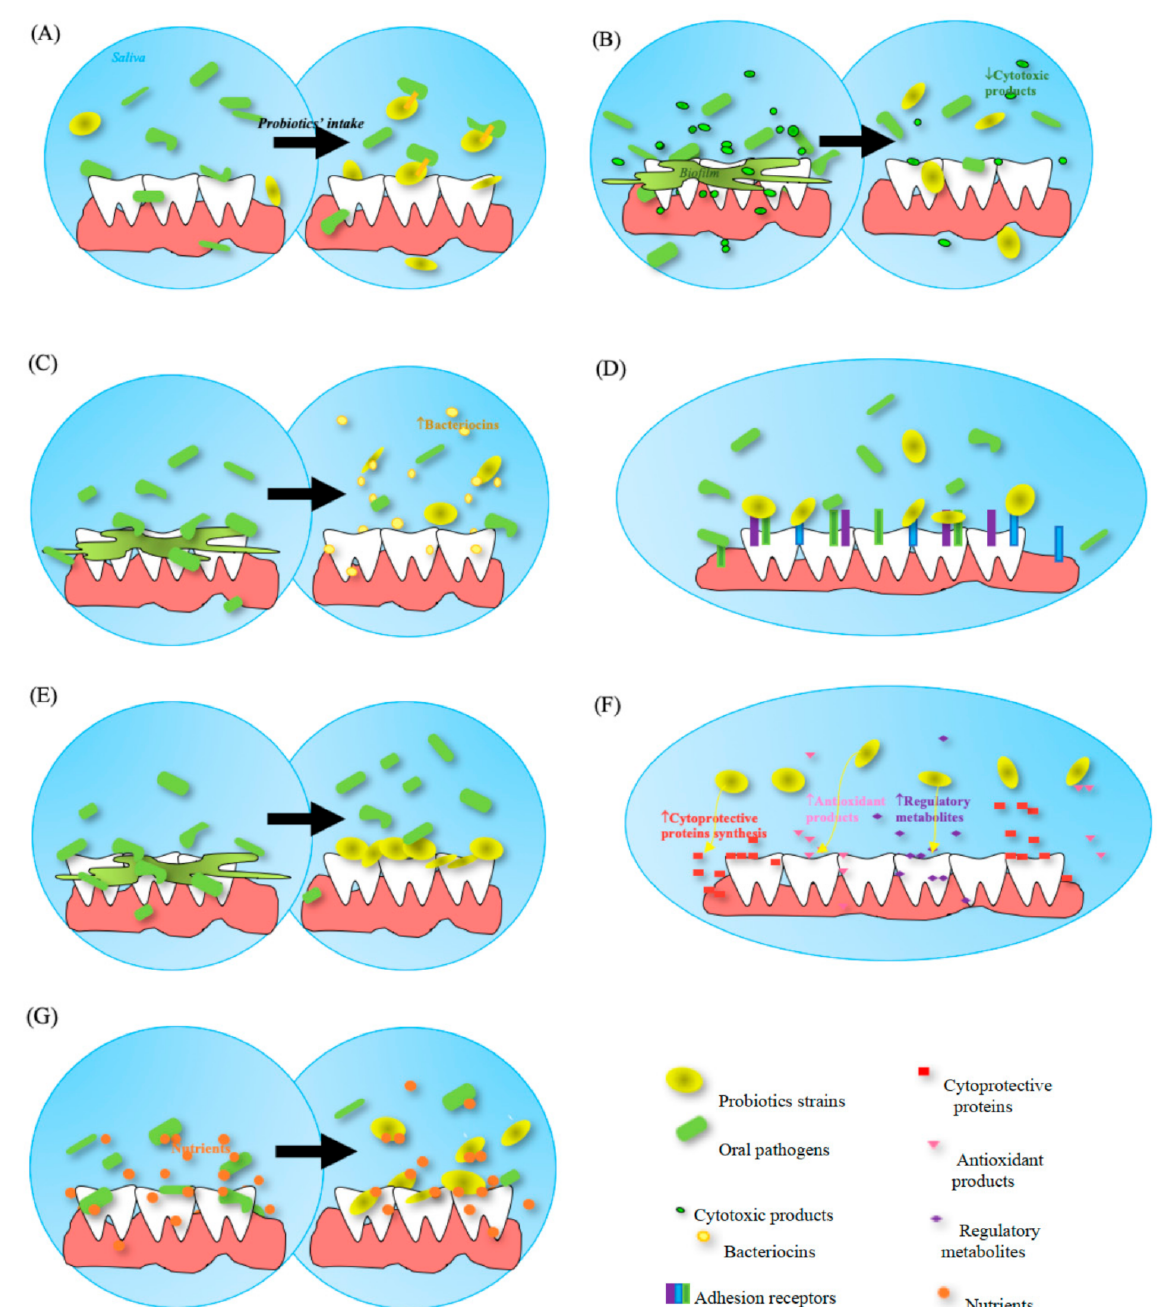
Figure 1. Potential mechanisms of action of probiotics in oral health and disease: ( A ) direct interaction with pathogens to prevent pathogen colonization; ( B ) antagonistic activity on pathogens cytotoxic metabolites, oral biofilm, and extracellular matrix; ( C ) synthesis of antibacterial agents (e.g., bacteriocins) against oral pathogens; ( D ) alter adhesion, aggregation, colonization, and proliferation of pathogens in oral tissues due to mechanisms of exclusion and competition; ( E ) coating oral tissues to protect oral surfaces from pathogens action; ( F ) maintain oral ecosystem balance by synthetizing cytoprotective proteins, antioxidant products, and regulatory metabolites on surface of oral cells; ( G ) competition for